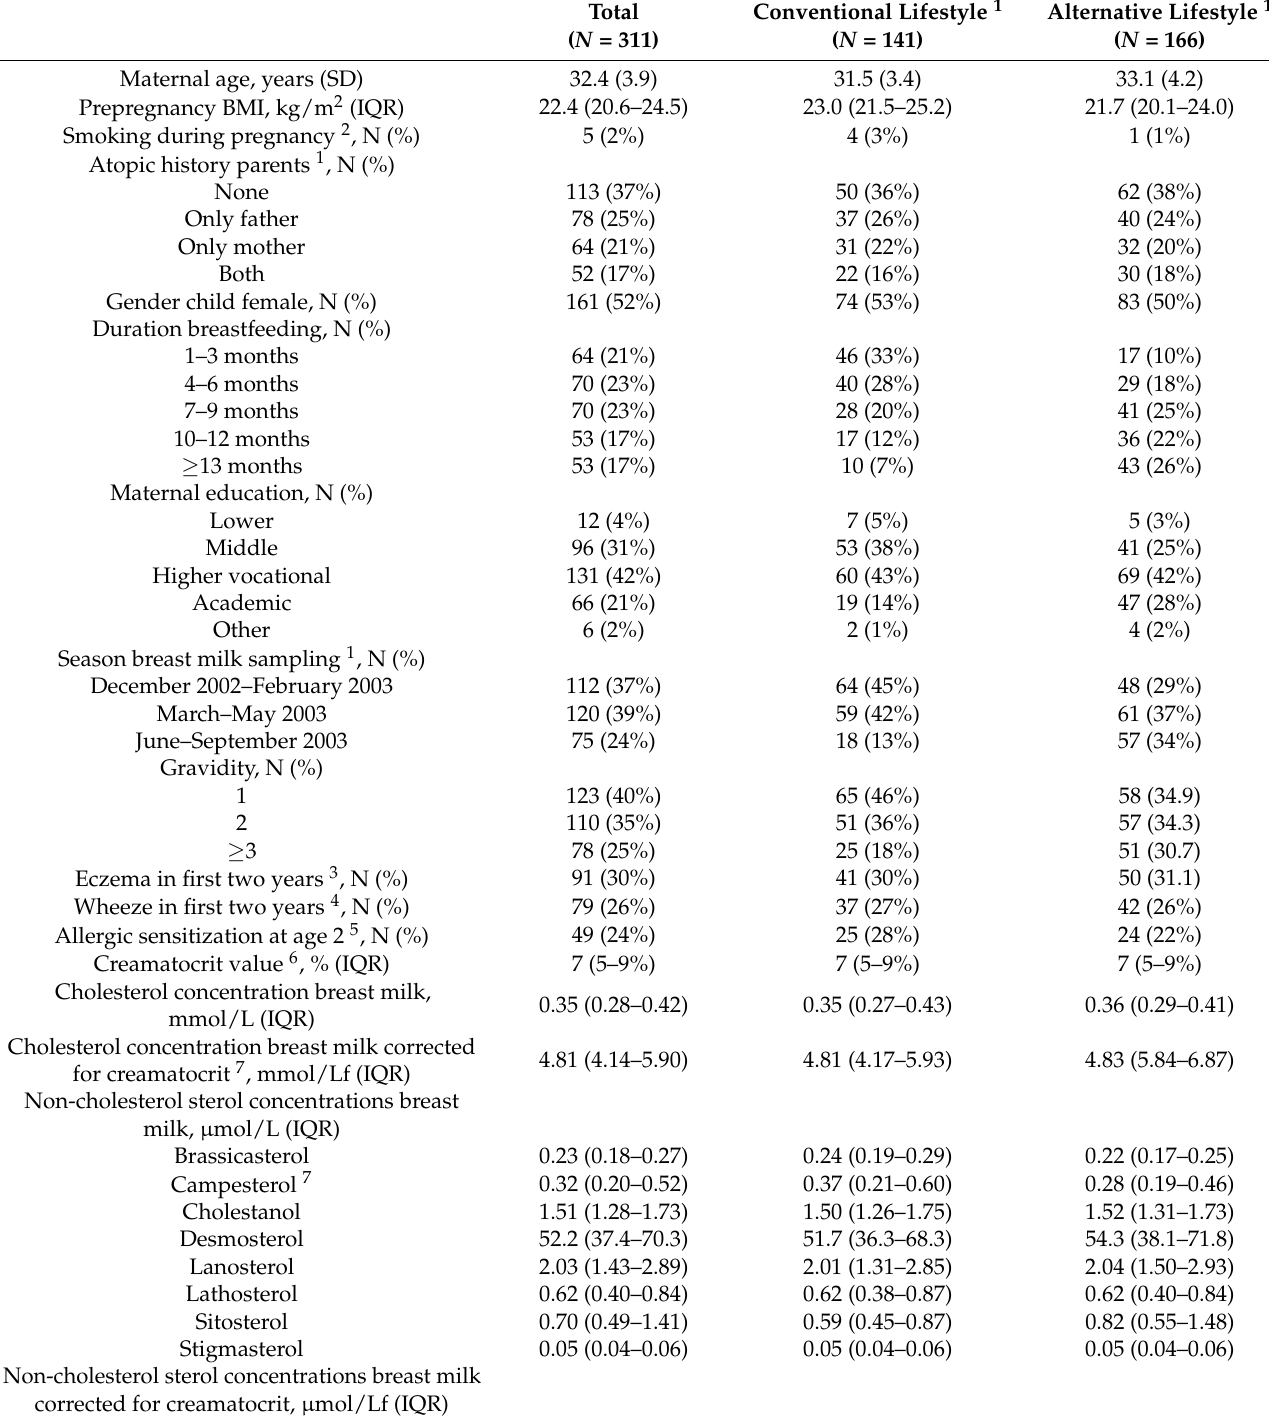
Table 1. Baseline characteristics of the KOALA-SUB cohort selected for this study. Data are shown as the mean (SD) or the median (Q1–Q3), unless otherwise